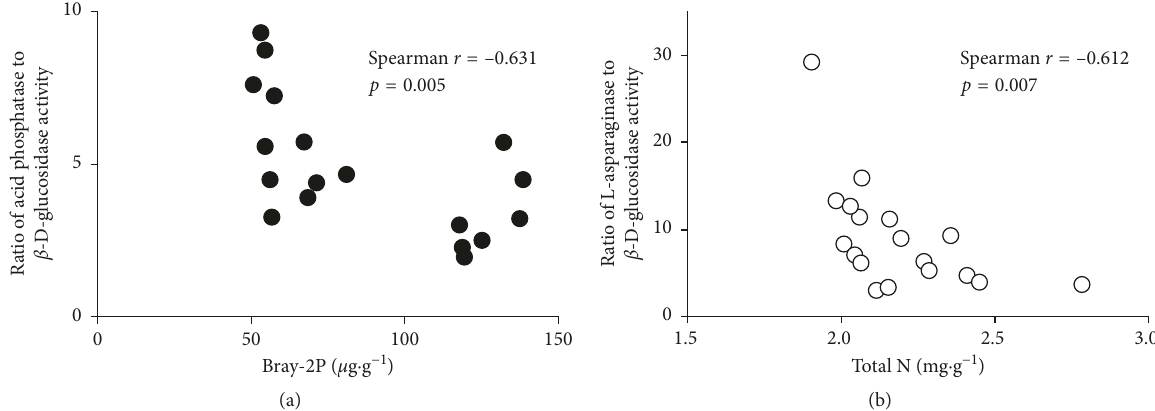
Figure 4: Relationships between Bray-2P and ratio of acid phosphatase to β -D-glucosidase activity (a) and between total N and ratio of L- asparaginase to β -D-glucosidase activity (b) in paddy